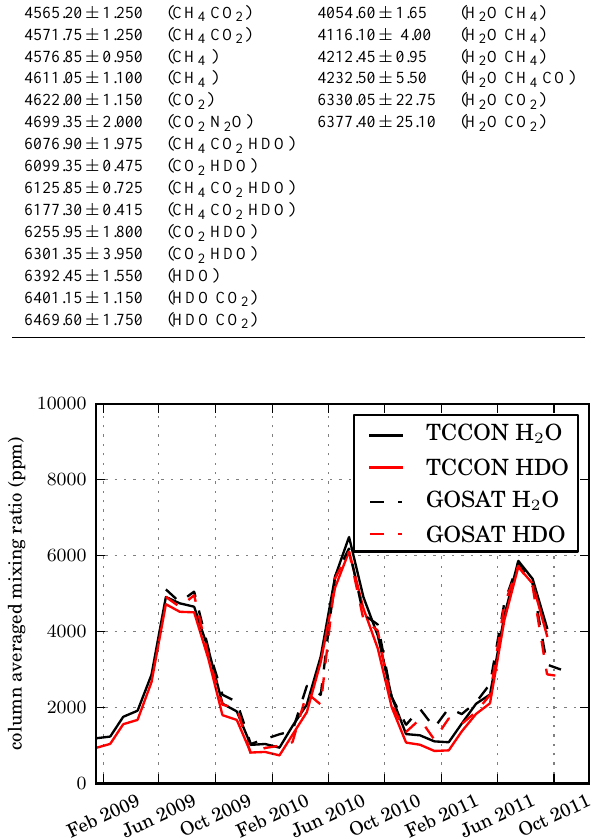
Fig. 5. Comparison of monthly HDO and H 2 O column amounts over the Lamont (Oklahoma) TCCON station (GOSAT coinci- dences within ± 3 ◦ latitude and longitude)